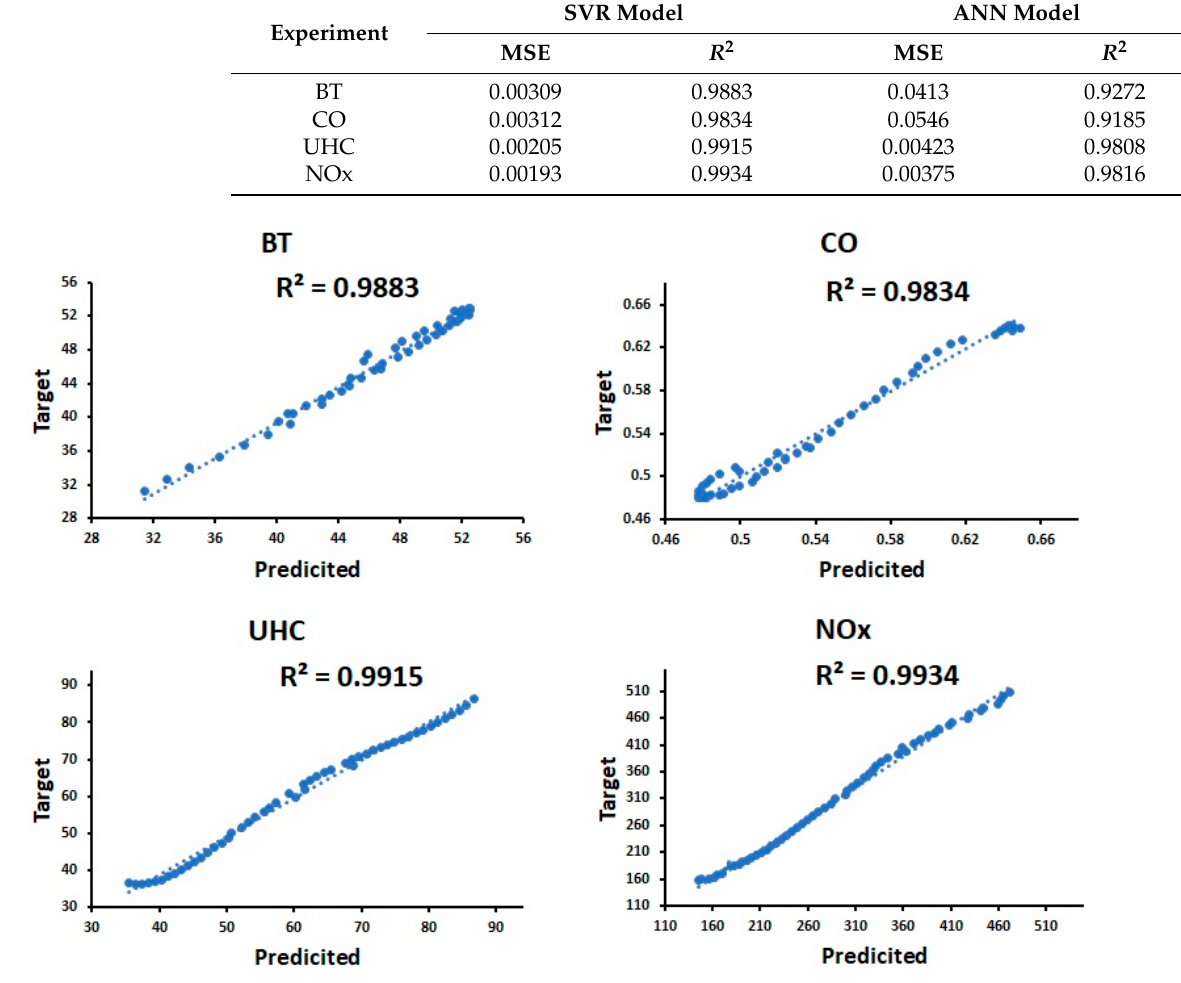
Figure 9. SVMR model prediction precision for each response.